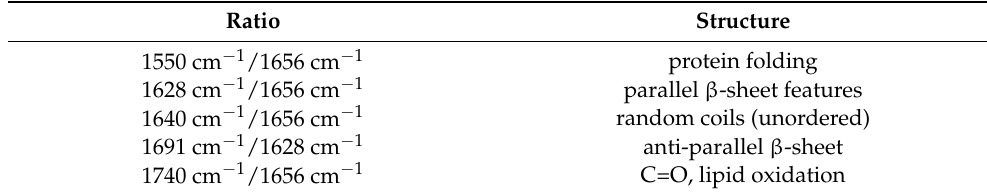
Table 2. Summary of bands ratios used for infrared spectra